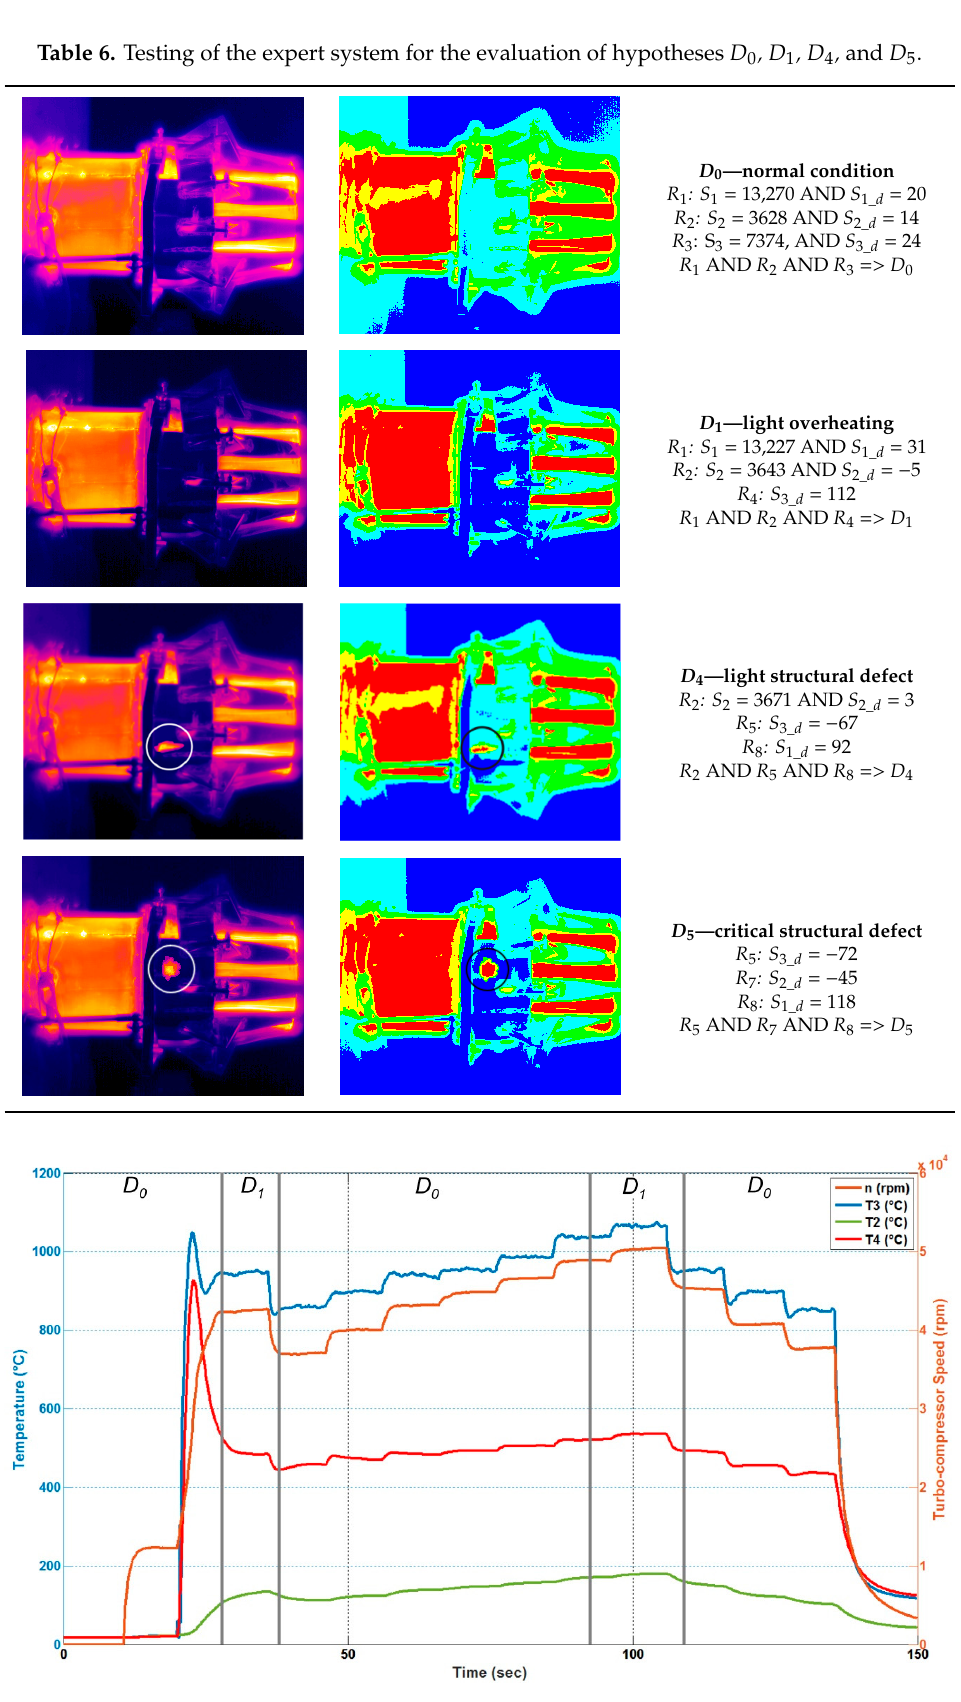
Table 6. Testing of the expert system for the evaluation of hypotheses D 0 , D 1 , D 4 , and D 5 .